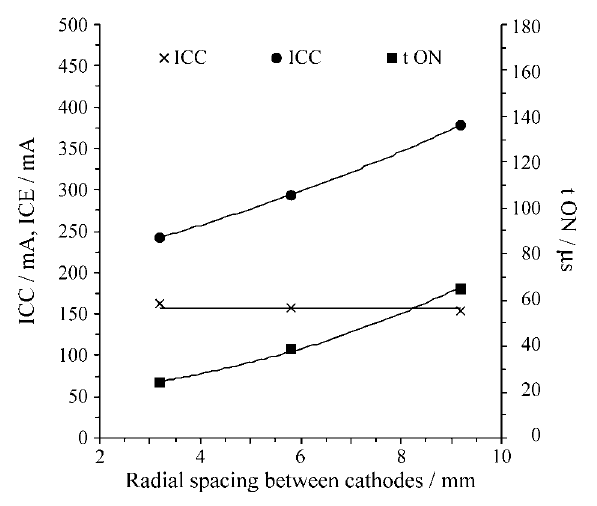
Figure 2. Average values, during the final 20 min of sintering, of the processing variables as a function of the radial spacing between cathodes.